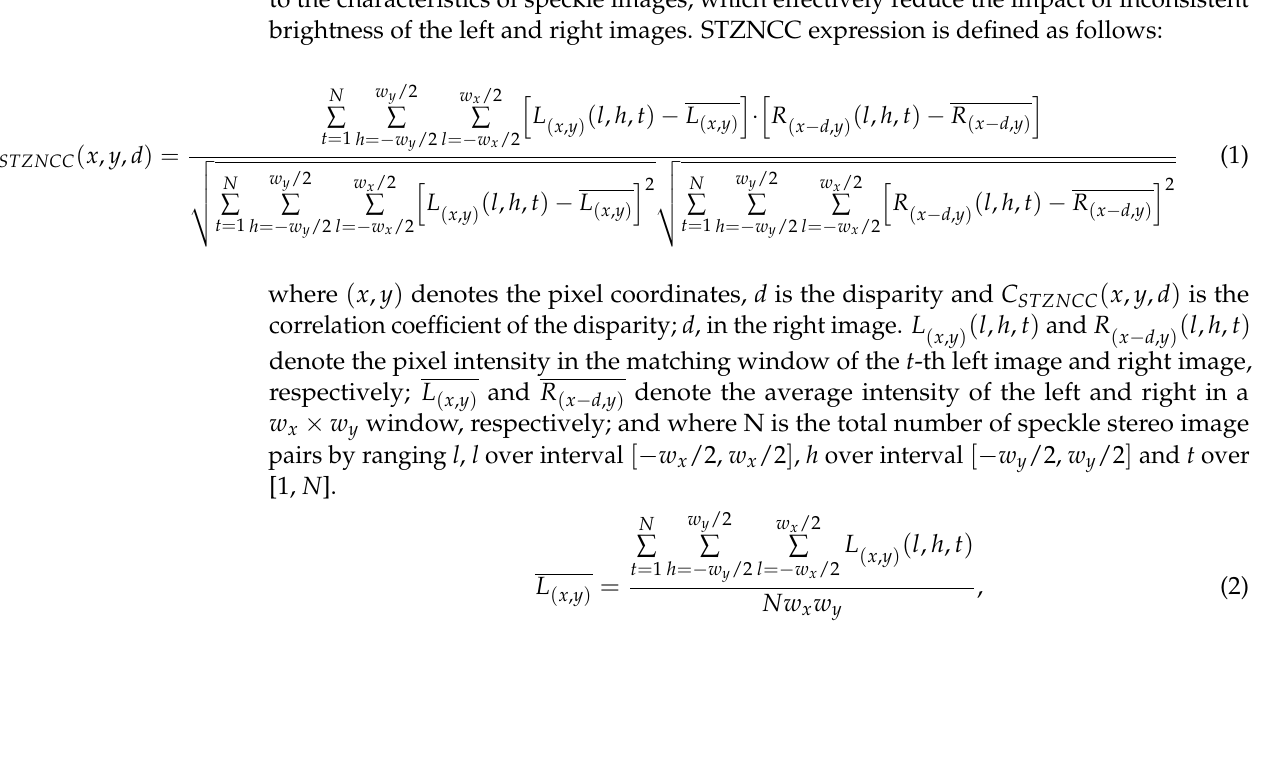
Figure 3. Stereo matching based on spatiotemporal correlation. Correlation coefficients are calculated between two cubes composed of correlation windows in the temporal and spatial domains.